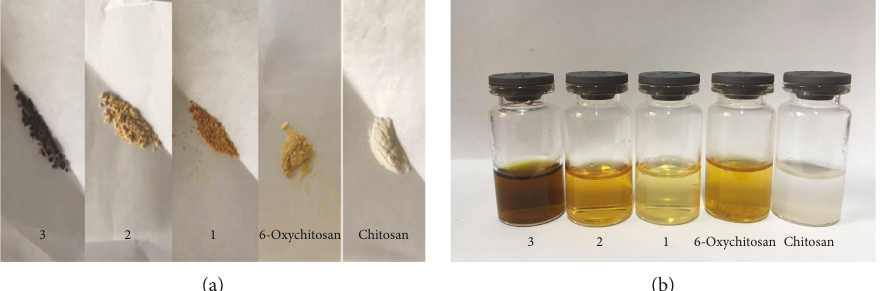
Figure 2: (a) The solidity of chitosan and chitosan derivatives. (b) The aqueous solution of chitosan and chitosan derivatives (neutral water, 10mg/ml).